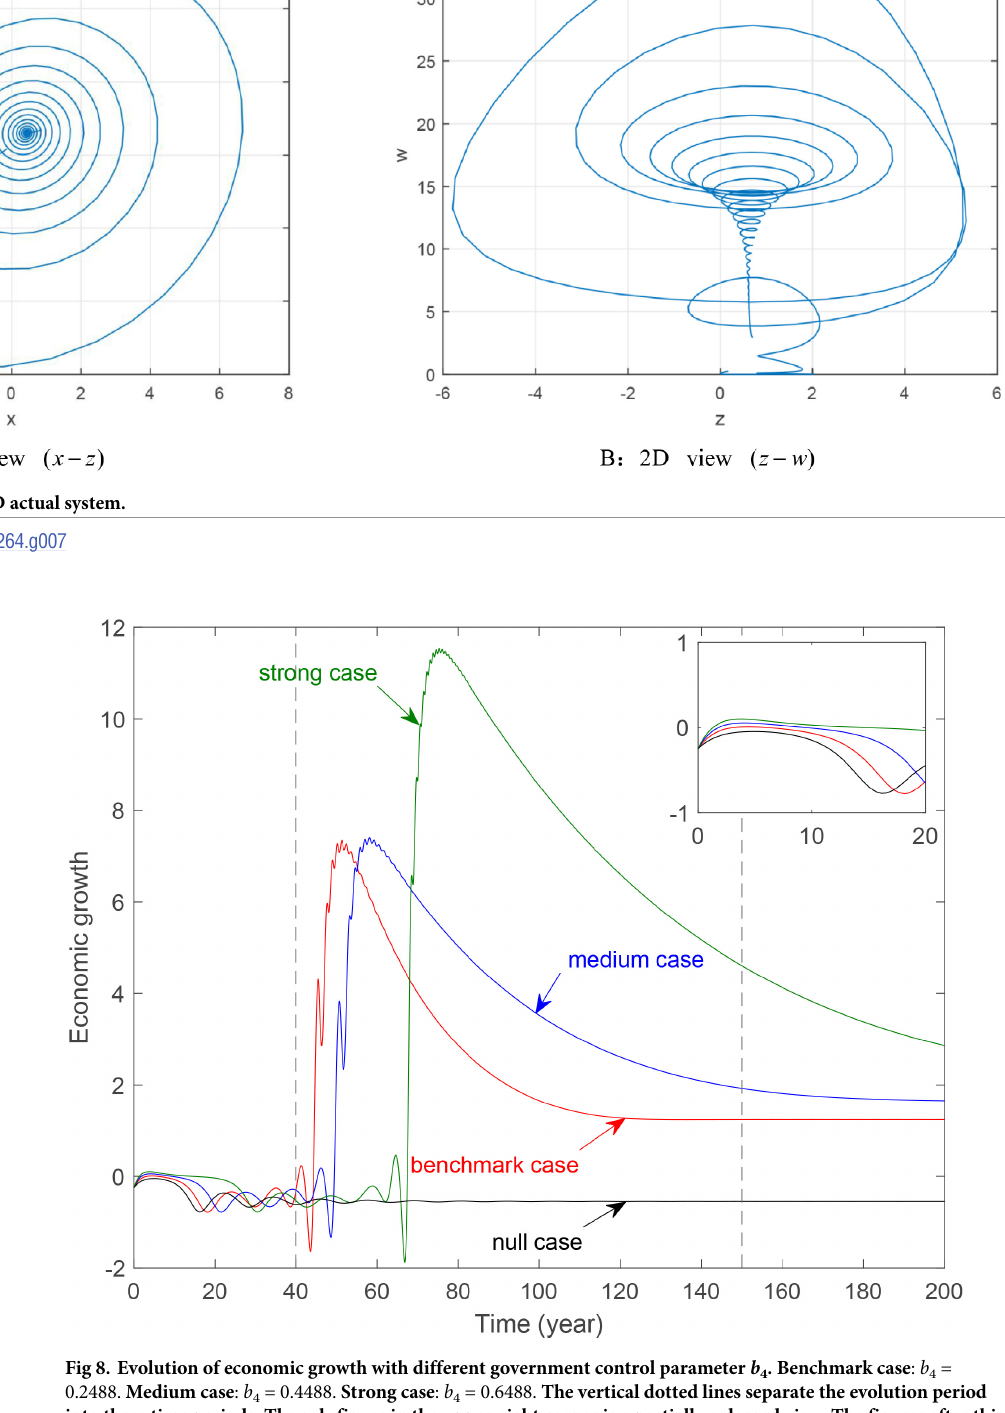
PLOS ONE | https://doi.org/10.1371/journal.pone.0221264 September 4,